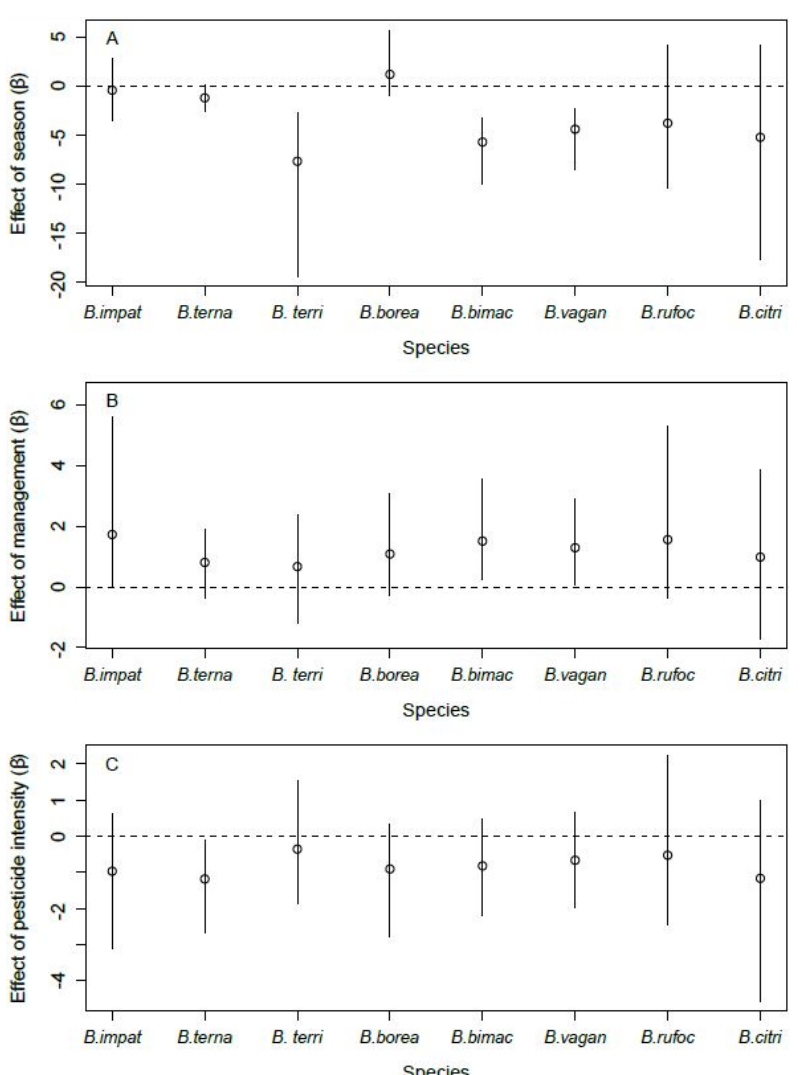
Figure 4. Effect of season (( A ), spring vs. fall), management (( B ), with enhancements vs. none), and intensity of pesticide use (( C ), low vs. high) on the site occupancy of the eight species of bumble bee queens sampled in orchards (2017–2019) in southern Québec, Canada. Error bars denote 95% Bayesian credible intervals around each estimate.